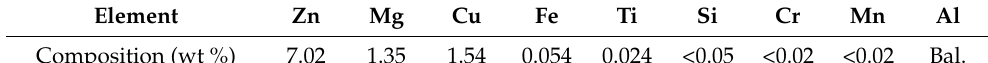
Table 1. Chemical compositions (wt %) of the 7085-T7452 aluminum alloy. Element